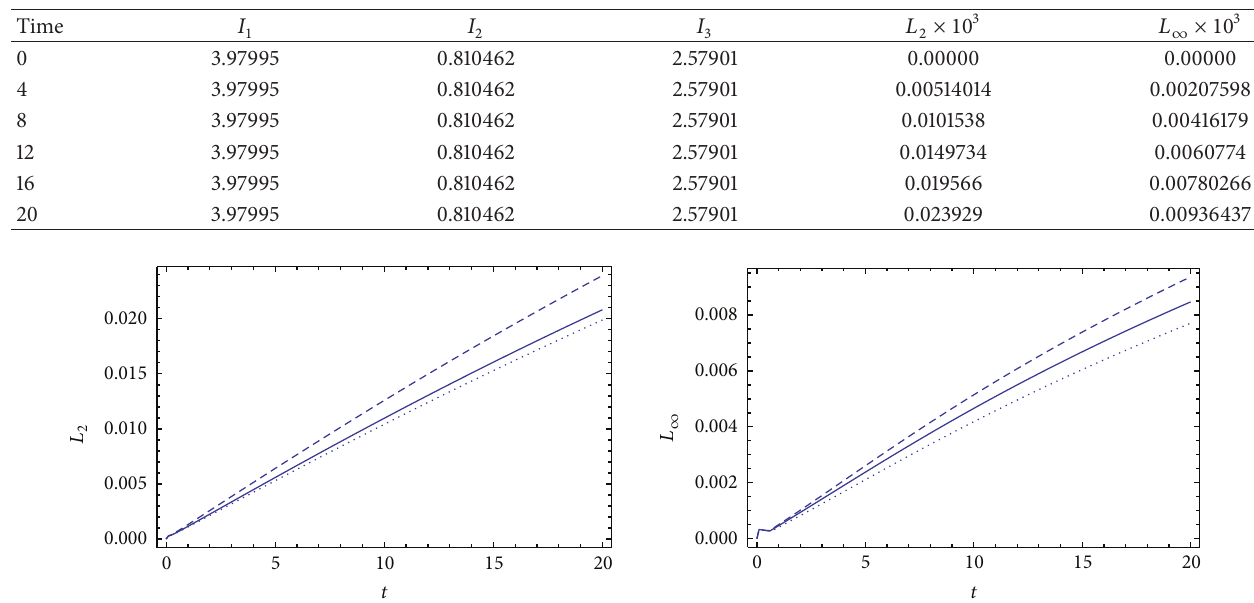
Table 5: Table comparing values obtained from the nonstandard numerical scheme (43) to the single solitary wave solution (8) for 𝑥 0 = 0 and 𝑣 = 0.1 , for 𝑥 ∈ [−50, 70] , and taking 𝑛 = 5000 and Δ𝑡 = 0.0001 .